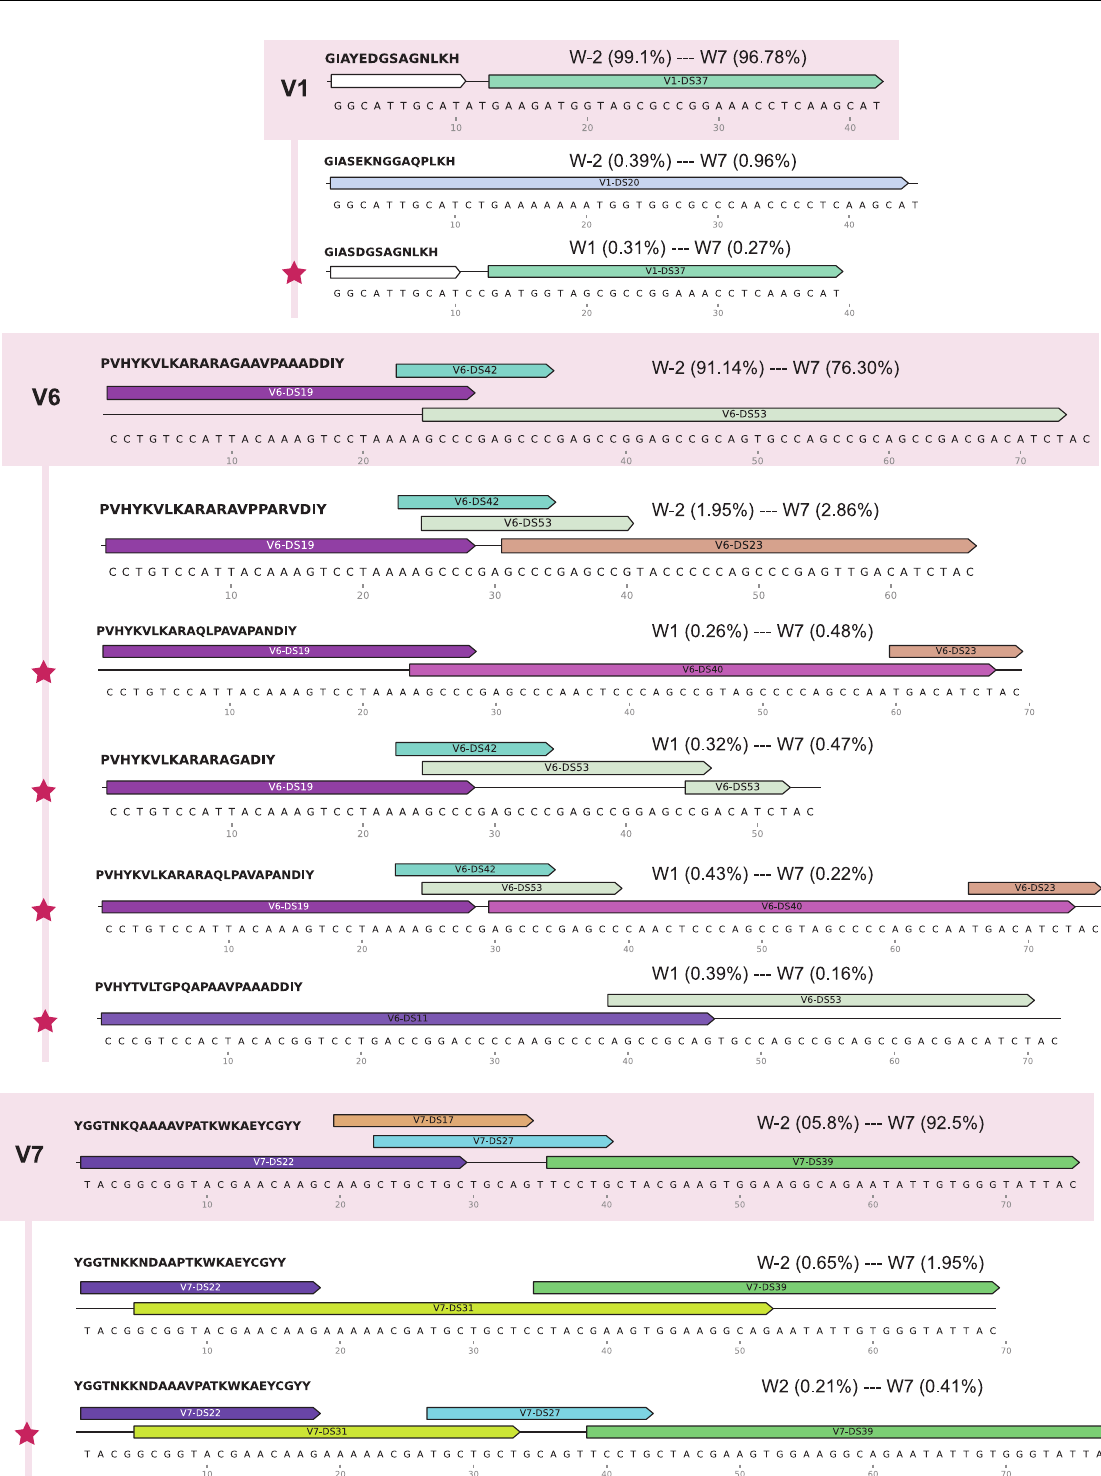
PLOS NeglectedTropical Diseases | https://doi.org/10.1371/journal.pntd.0009753 September 7,